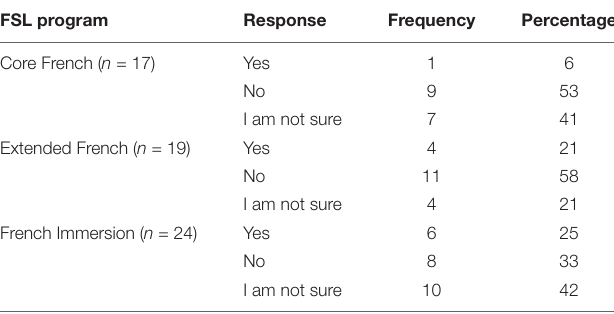
TABLE 3 | Distribution of multiple-choice responses for question 2: Do students in your French program act differently from other students in your same secondary